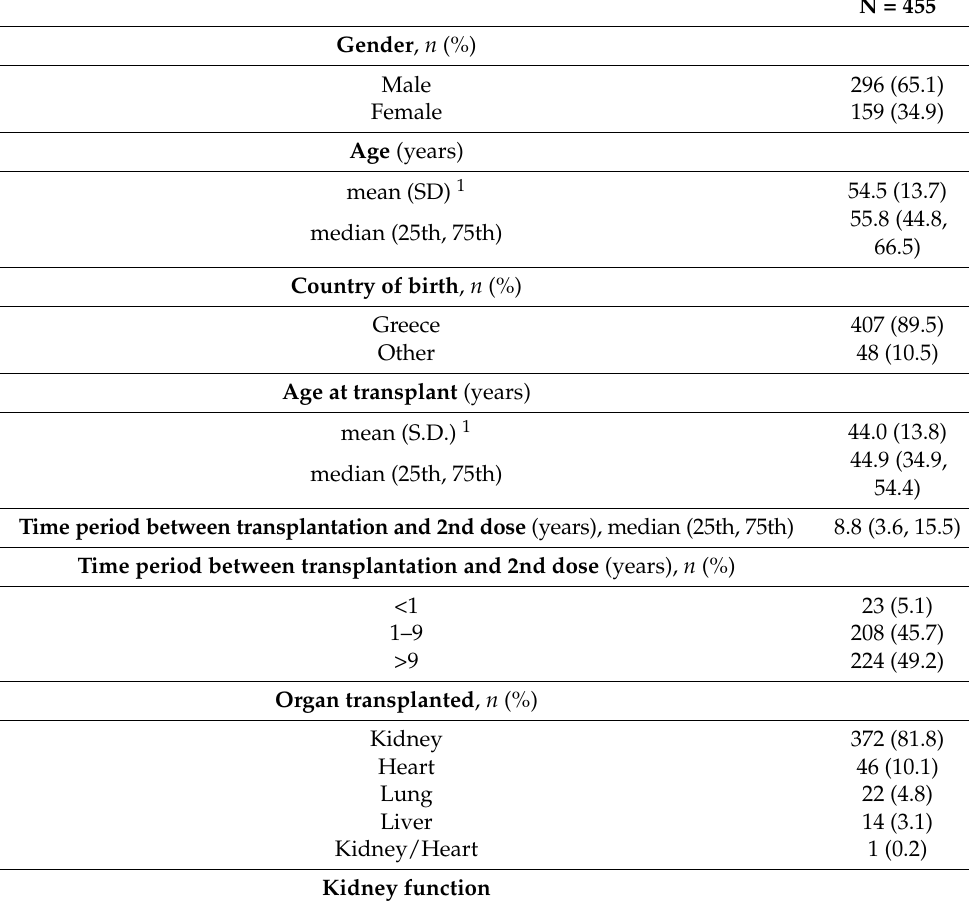
Table 1. Demographics and clinical characteristics of the study